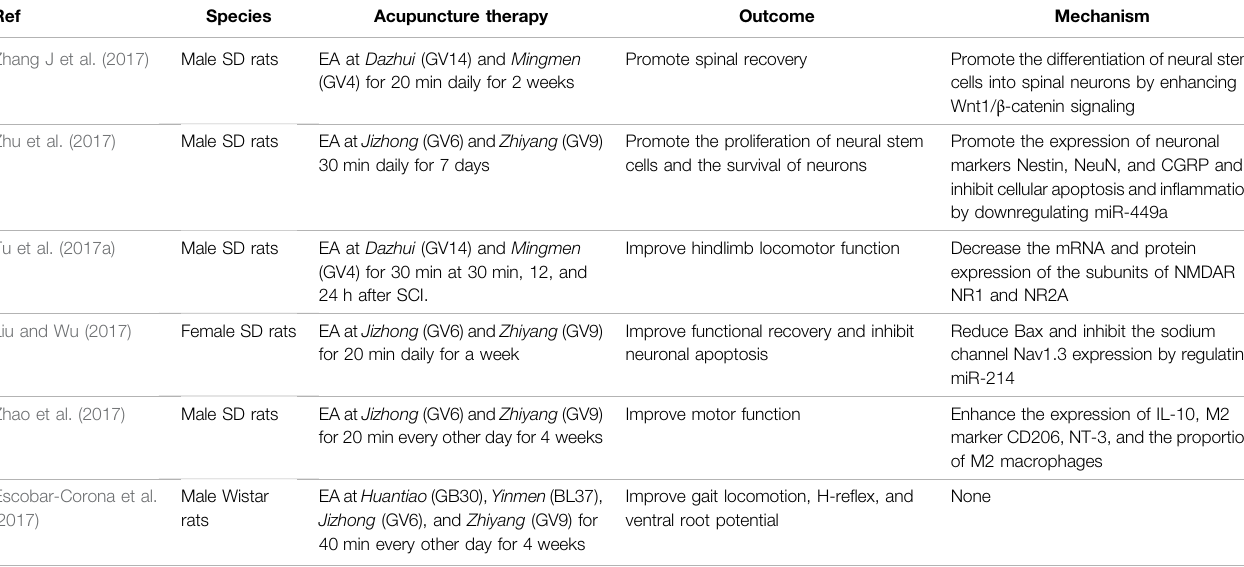
Abbreviations: α CaMKII: calmodulin-dependent protein kinase; BDNF: brain-derived neurotrophic factor; CGRP: calcitonin gene-related peptide; EA: electroacupuncture; MSC: mesenchymalstem cell;NMDARs:N-methyl-D-aspartate (NMDA)receptors; NSCs:neuralstem cells;NT-3: neurotrophin-3;RAMP:receptoractivity-modifyingprotein; SCI:spinal cord